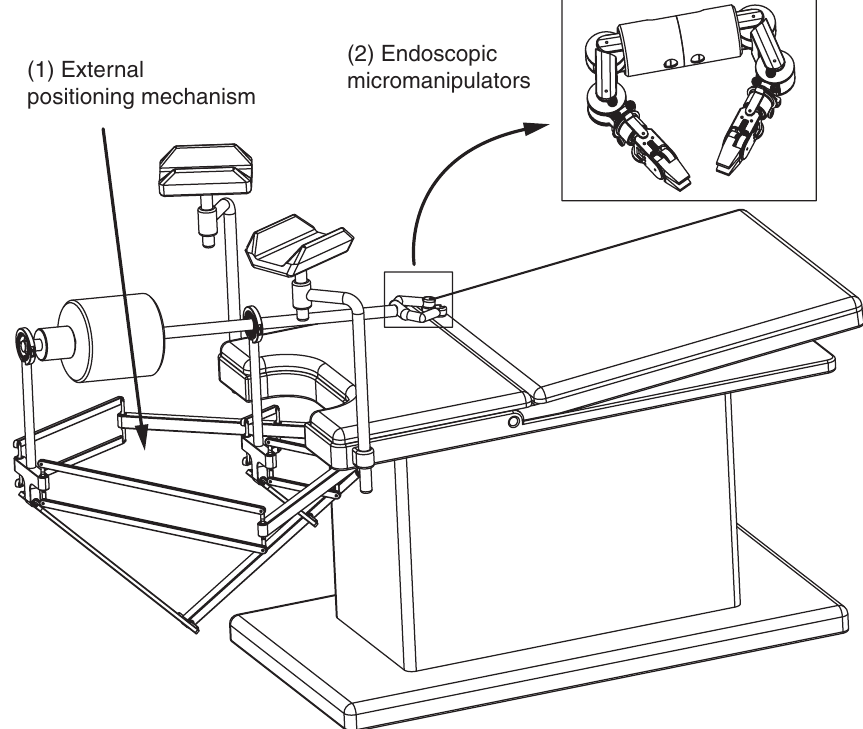
Fig. 3. Conceptual design of the complete surgical